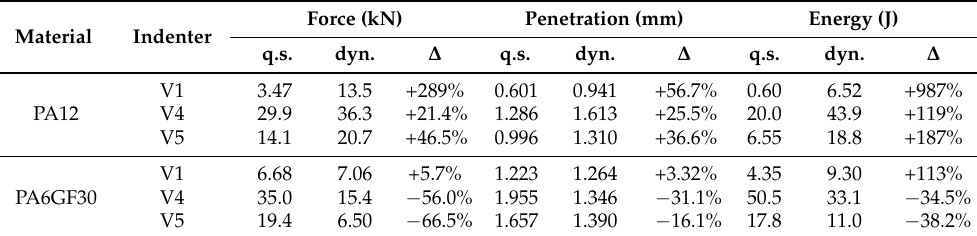
Figure 11. Exemplary high-speed sequences from a dynamic SHPB test on a PA6GF30 busbar in combination with impactor V4. Table 2. Comparison of force, penetration and energy values between the quasi-static (q.s.) and the dynamic (dyn.) experiments for the impactor types V1, V4 and